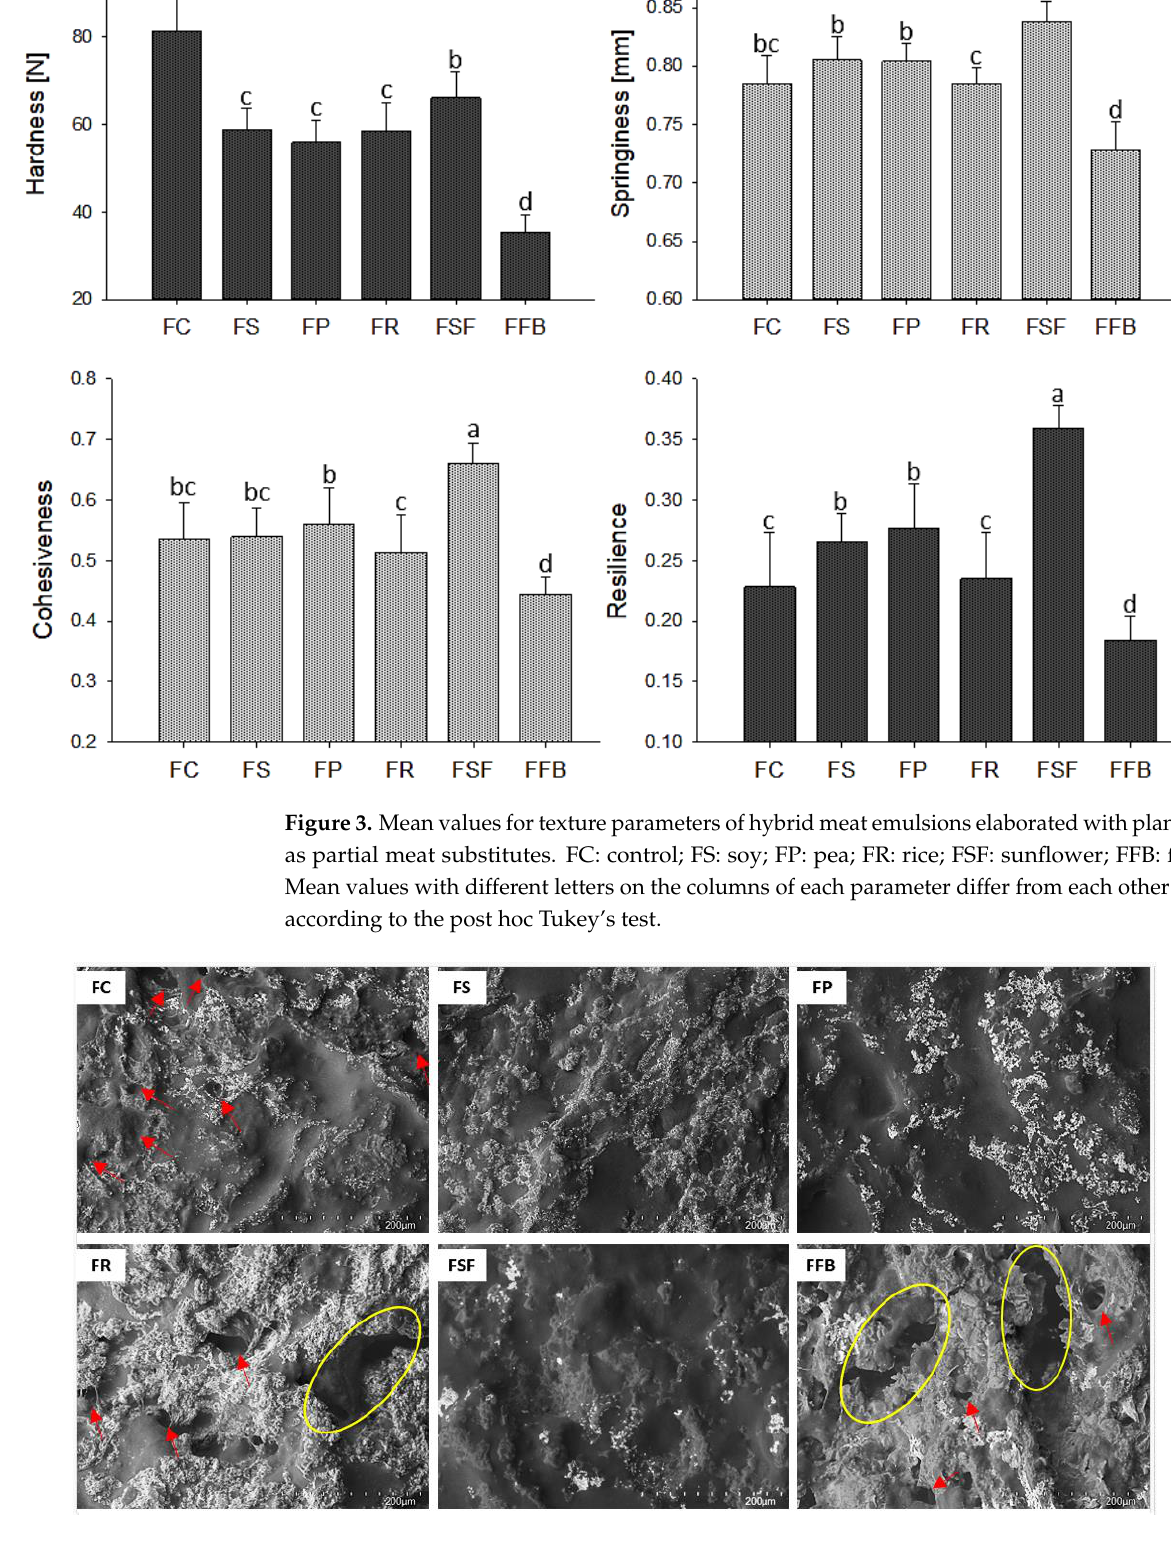
Figure 4. Microstructure images (magnification 250 × , scale bar 300 µ m) of hybrid meat emulsions elaborated with plant proteins as partial meat substitutes. FC: control; FS: soy; FP: pea; FR: rice; FSF: sunflower; FFB: fava